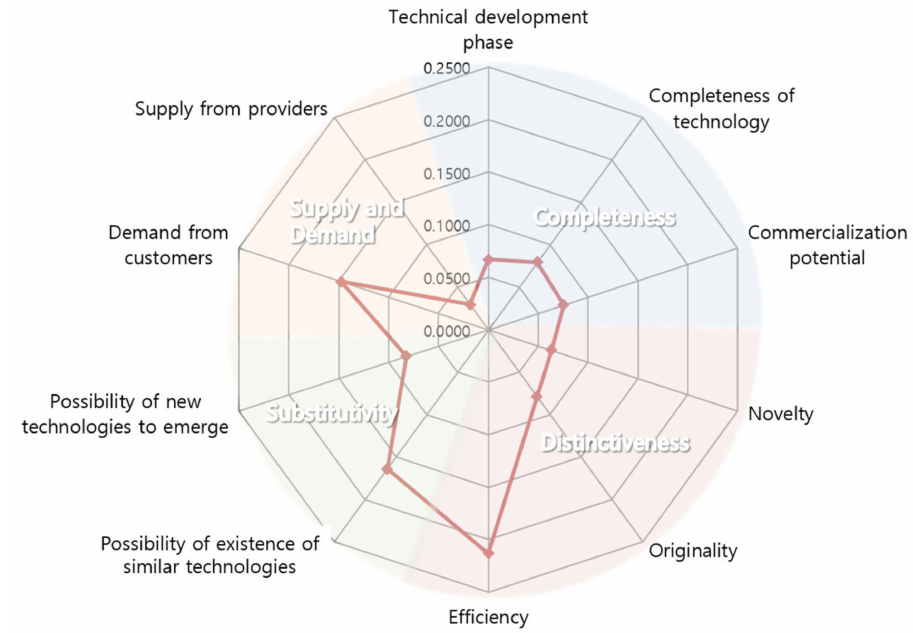
Figure 5. Radar diagram of relative weights of each criteria and